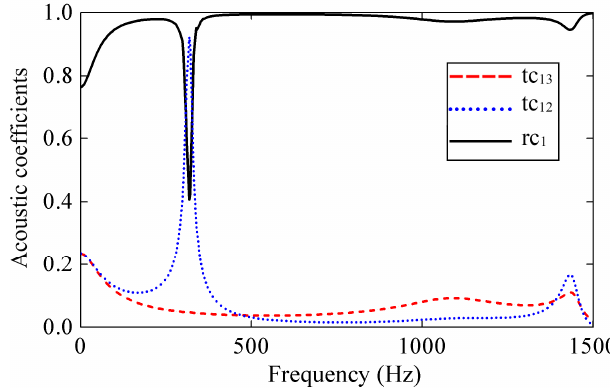
Figure 6. Amplitude of the transmission and reflection coefficients of discharge chamber with particle velocity imposed on the boundary of head-end valve.